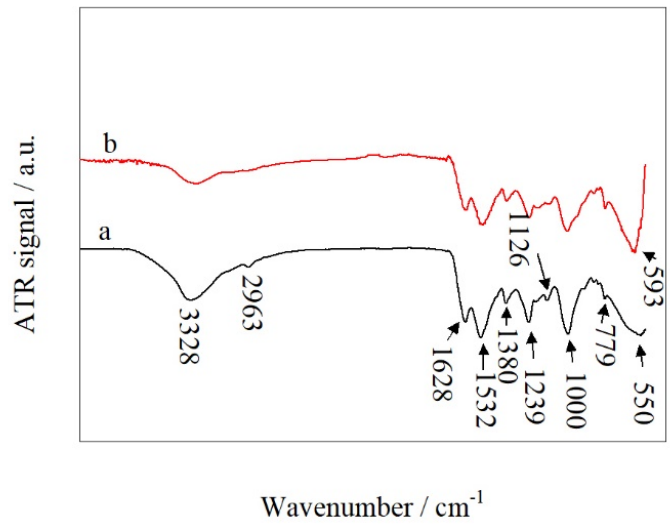
Figure 4. ATR-IR spectra of ( a ) the control UF and ( b ) UF/3% CuSO 4 . The ATR-IR spectrum of the control UF resin (Figure 4a) featured a peak at 550 cm -1 . This peak was shifted to 593 cm -1 , following the addition of 3% copper (II) sulfate (Figure